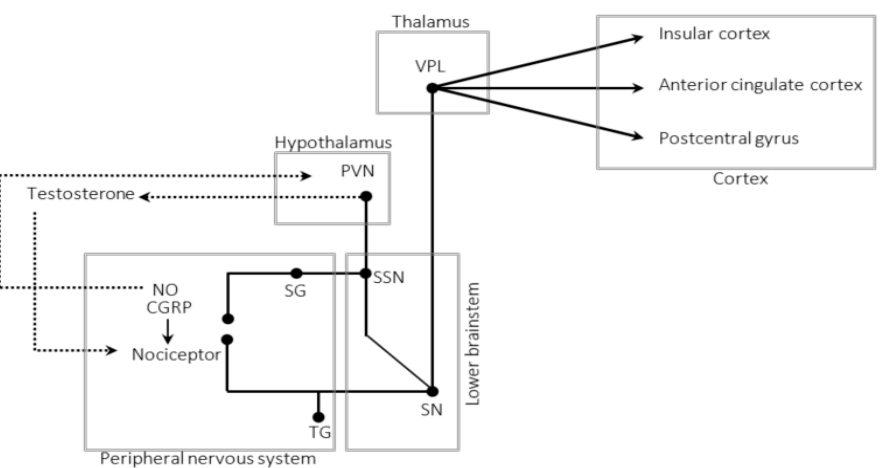
Figure 1. Summary of the different pain threshold-influencing mechanisms potentially implicated in the pathophysiology of cluster headache. The afferent part of the trigeminal–autonomic reflex runs through the trigeminal nerve and the trigeminal ganglion to the brain stem; the efferent part originates in the superior salivatory nucleus, runs through the facial nerve and the sphenopalatine ganglion, and modulates the release of CGRP and NO that lower the pain threshold (their concentration is increased in episodic cluster headache). The paraventricular nucleus of the hypothalamus also modulates pain perception possibly through its connection with the superior salivatory nucleus; this nucleus might relay the circadian rhythmicity of pain perception. Furthermore, testosterone (reduced during the active period of cluster headache) also influences pain perception possibly through modulation of nociceptors. Not depicted are pain-modulating descending pathways; their activity is influenced by melatonin (reduced concentration during the active period of cluster headache). Moreover, we did not depict the sympathetic nervous system that also has circadian rhythmicity. Please see text for further details. Solid lines depict anatomical connections; dashed lines refer to the action of hormones CGRP—calcitonine gene ‐ related peptide; NO—nitrogen oxide; PVN—paraventricular nucleus; SG—sphenopalatine ganglion; SN—spinal nucleus of the trigeminal nerve; SSN—superior salivatory nucleus; TG—trigeminal ganglion; VPL—ventral posterolateral nucleus of the Thalamus .